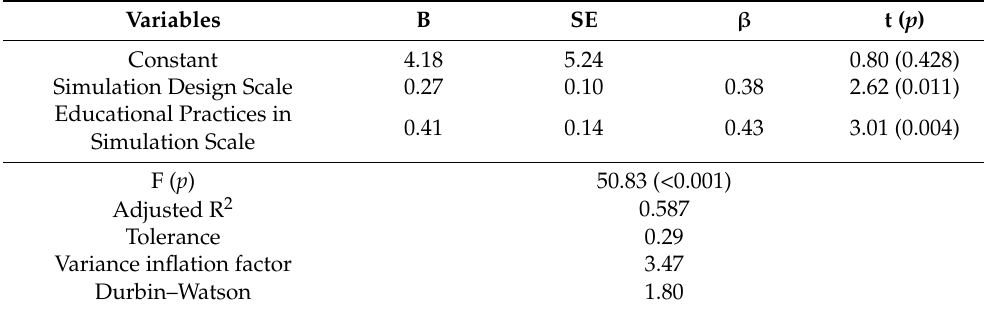
Table 5. Factors associated with Student Satisfaction and Self-confidence in Learning ( n =